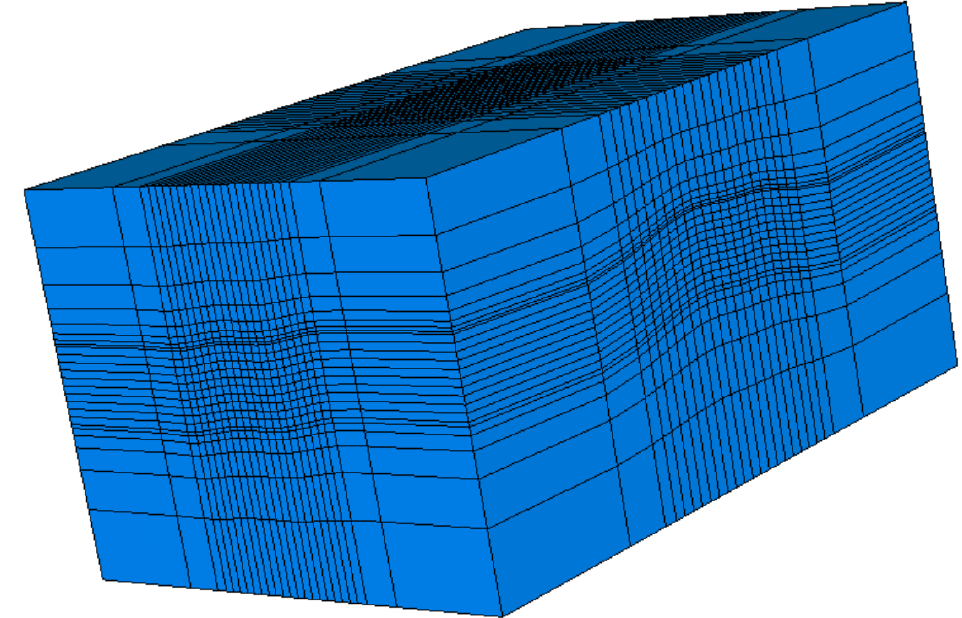
Figure 22. Conforming